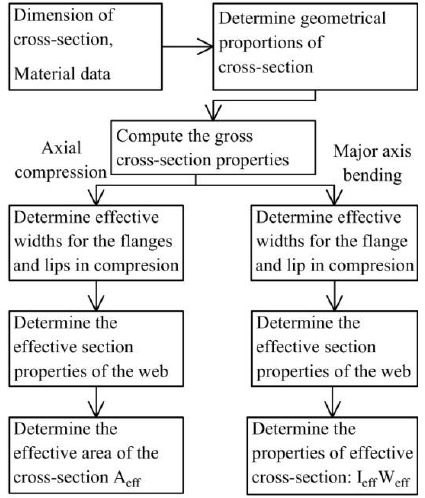
Figure 1: Flow chart: Calculation of effective section